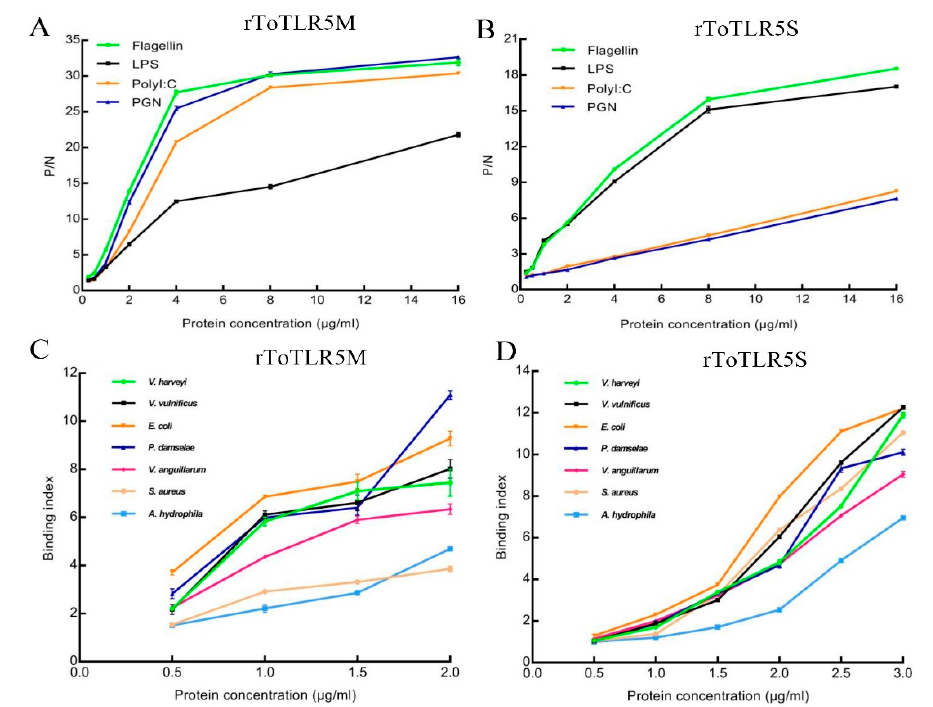
Figure 9. ELISA analysis of the interaction between rToTLR5M ( A , C ) and rToTLR5S ( B , D ) to pathogen-associated molecular patterns (PAMPs) ( A , B ) and bacteria ( C , D ), respectively. The microtiter plates were coated with PAMPs and bacteria, and then incubated with different concentrations of recombinant protein. The interaction between protein and PAMPs/bacteria were detected by composite anti-His polyclonal antiserum at 450 nm. Results were representative of an average of three experiments.